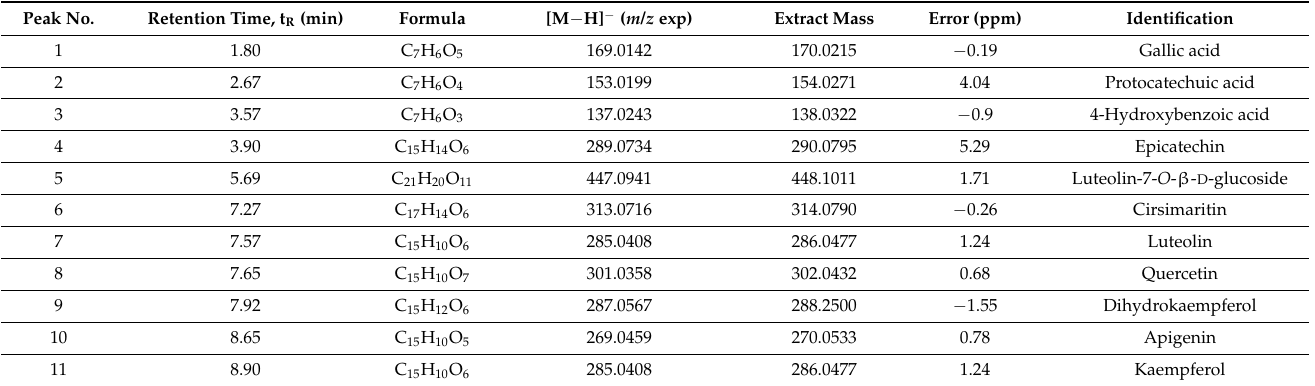
Figure 2. LC ‐ DAD ‐ MS chromatograms of the acetone extract of E. phaseoloides leaves. ( A ) Total ion chromatogram (TIC) spectrum. ( B ) Detected at 280 nm. ( C ) Detected at 330 nm. The numbering and identification of the peaks refer to Table 2. Table 2. Characterization of the isolated and/or standard compounds from AE by